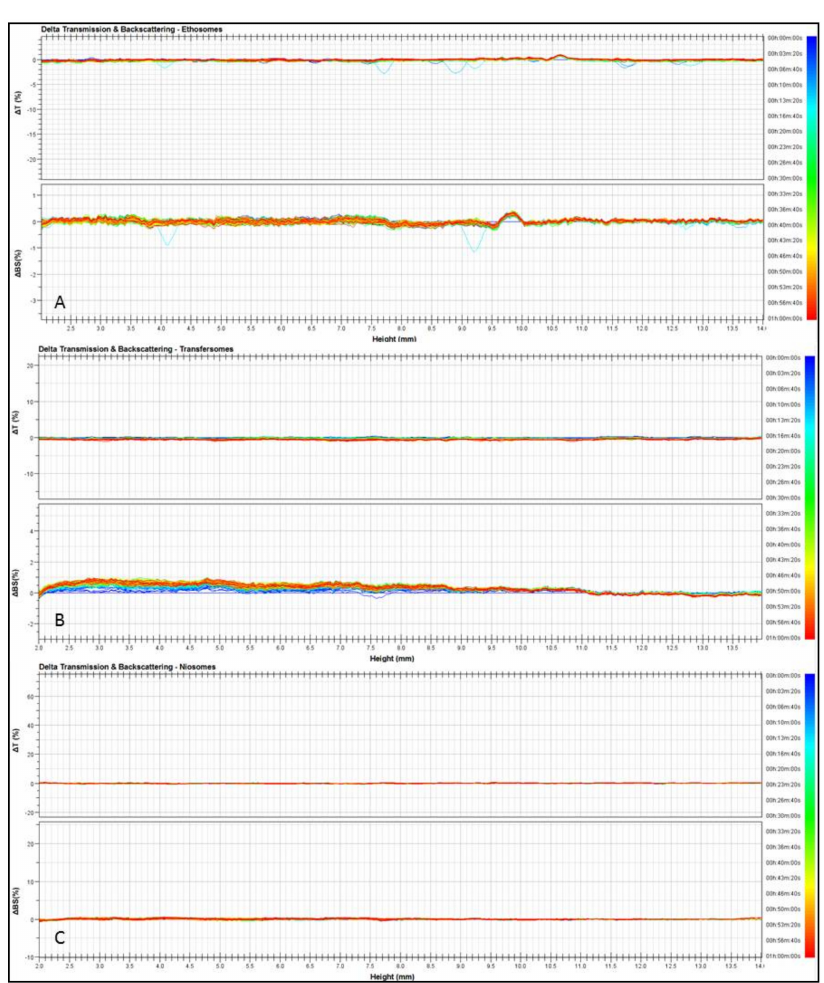
Figure 1. Transmission and backscattering profiles of ethosomes ( A ), transfersomes ( B ) and niosomes ( C ) determined by Turbiscan Lab ® Expert. Various runs were representative of three independent experiments. Data are reported as a function of time (0–1 h) and sample height.